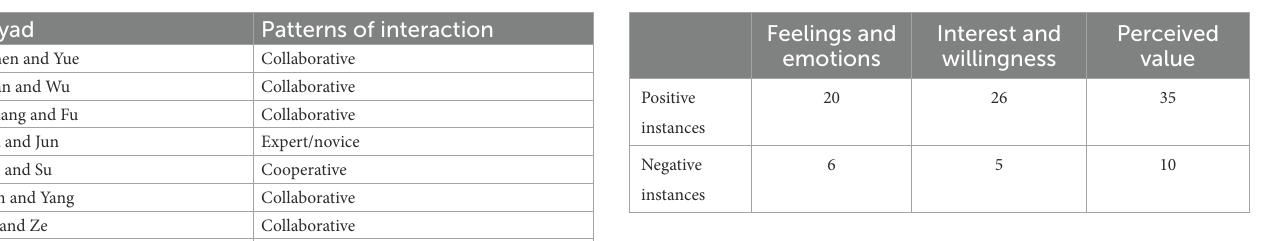
TABLE 6 Results for social engagement. TABLE 7 Results for affective